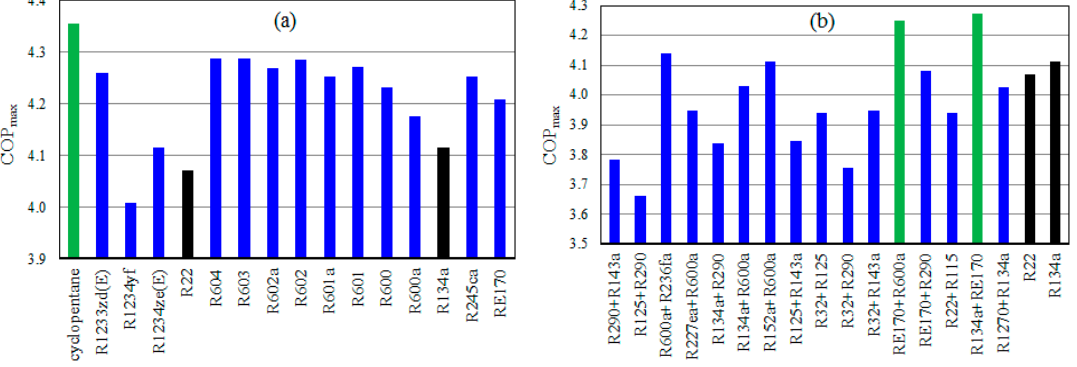
Figure 8. The COP max of TSVCRC using pure refrigerants ( a ), and mixed refrigerants ( b ).